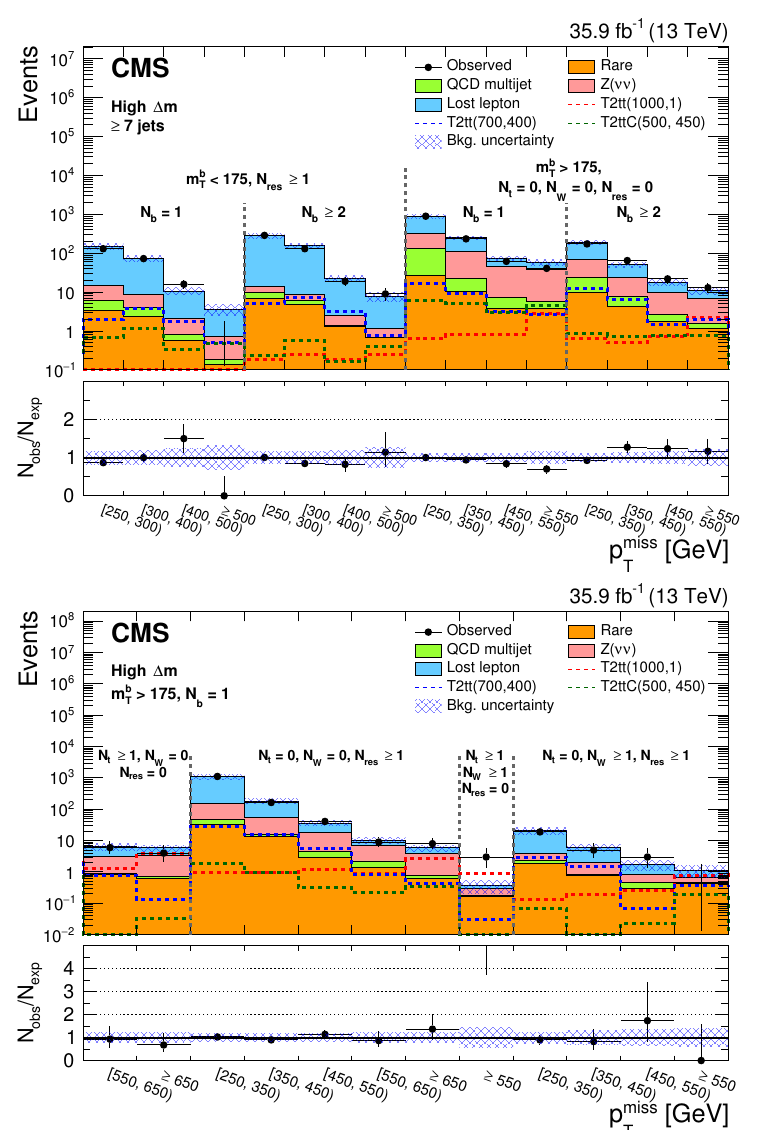
Figure 7 . Observed data events and SM background predictions for the high (cid:1) m search regions with N j (cid:21) 7 (upper), and m b > 175 GeV and N b = 1 (lower). Details of the selection applied is T displayed on each plot. Ratios of the observed to SM predicted event counts are shown in the lower panel of each plot. The shaded blue band represents the statistical and systematic uncertainty on the prediction. The one SR for which the result is not visible in the lower panel is discussed in the text. Units are GeV.